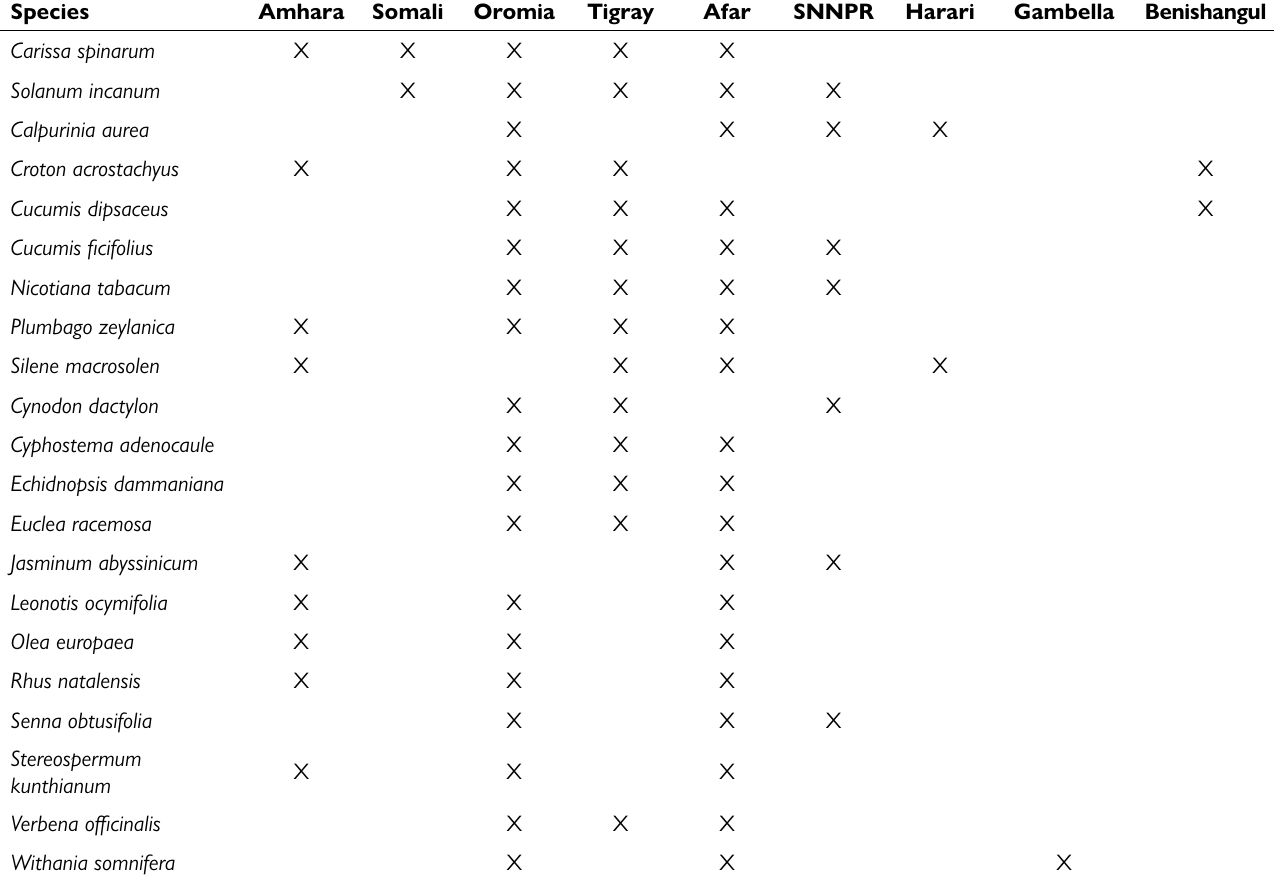
Table 2. List and regional distribution of ethnomedicinal plant species used for snakebite treatment present in at least three regions of Ethiopia.